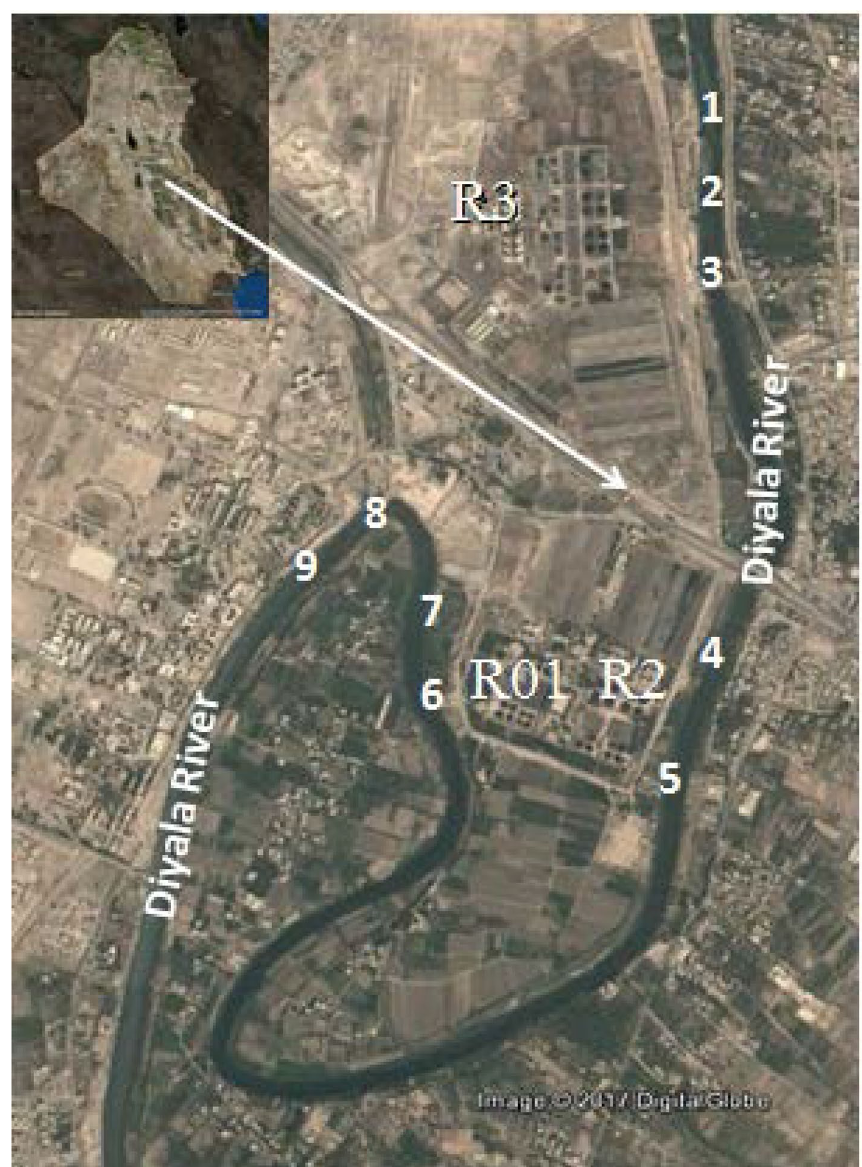
Fig. 1 The study area. Repro- duced with Permission from Image